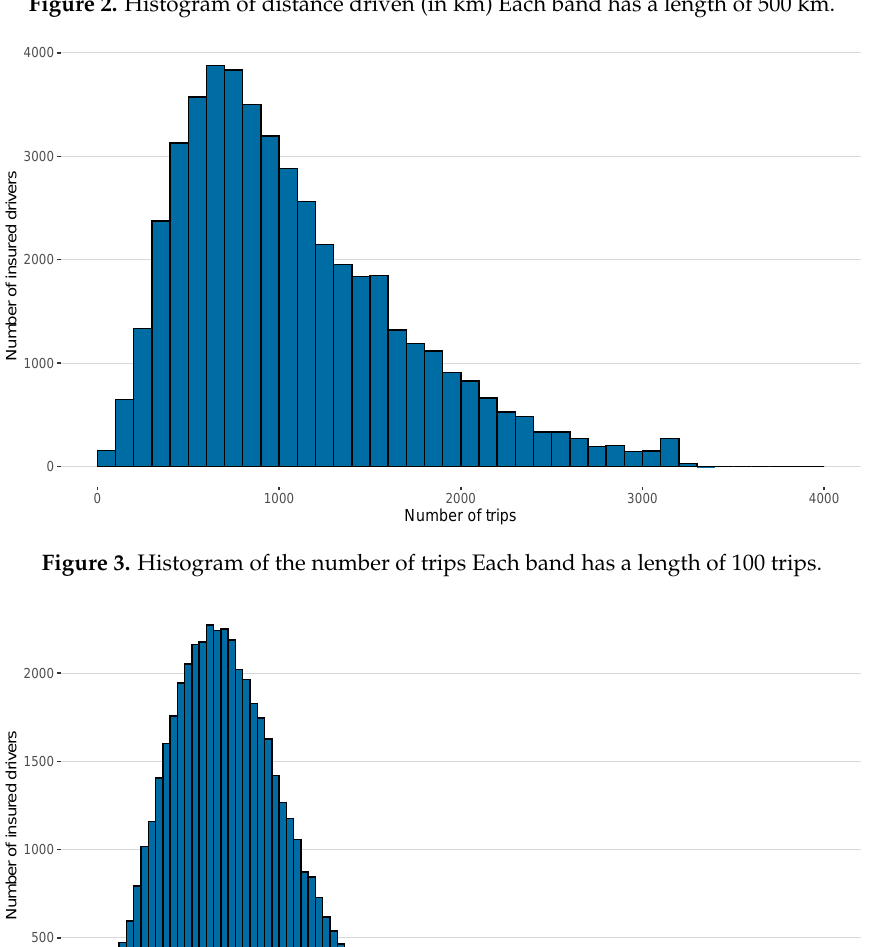
Figure 2. Histogram of distance driven (in km) Each band has a length of 500 km.